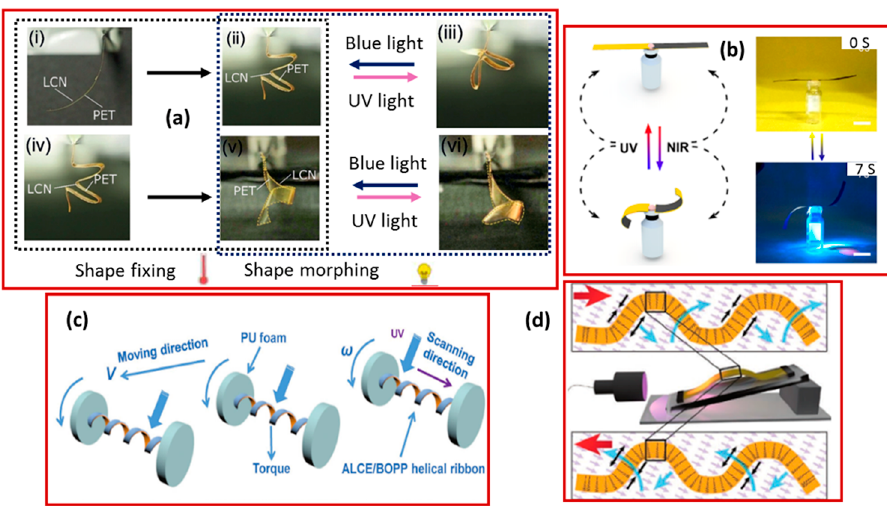
Figure 7. ( a ) Demonstration of shape fixing and shape morphing possibilities using a single actuator strip (Reprinted from Annalen der Physic [105]. Copyright (2012) John Wiley and Sons). ( b ) Schematic diagram and real deformation of the bending state and construction of the actuator under NIR and UV lamp (Reprinted (adapted) with permission [107]. Copyright (2020) American Chemical Society). ( c ) Mechanism of various UV-induced actuators based on bilayer LCPs (Reprinted (adapted) with permission [108]. Copyright (2017) John Wiley and Sons). ( d ) Schematic diagram of a polymeric film that was constrained at both ends and reacted with an oblique-incidence light source (left). The blue arrows show the way the film deformed while the red ones indicate the propagation direction of the wave (Reprinted (adapted) with permission [96]. Copyright (2019) John Wiley and Sons).